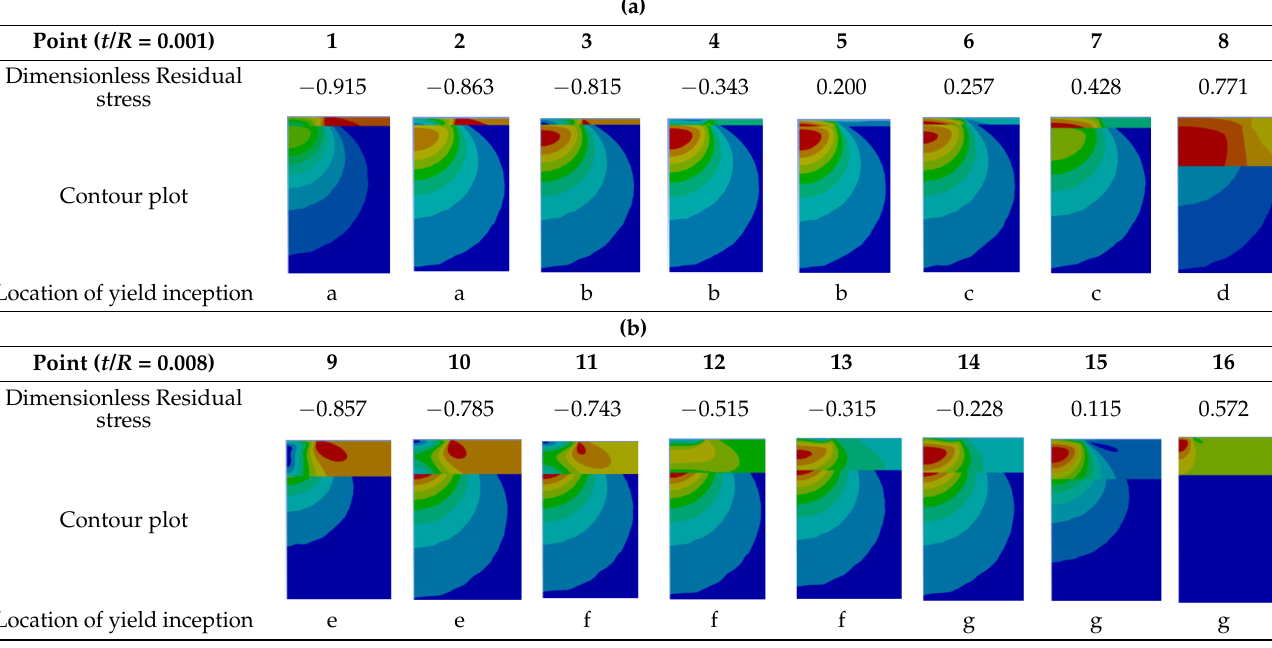
Table 3. Contour plots of von Mises stress at yield inception of cases with different residual stresses and different surface layer thicknesses ( E s = E l = 200 GPa, Y s = Y l = 600 MPa, number 1–24 are the labels of the points in Figure 5, and letters a–i denote the locations of the yield inception summarized in Figure 8).